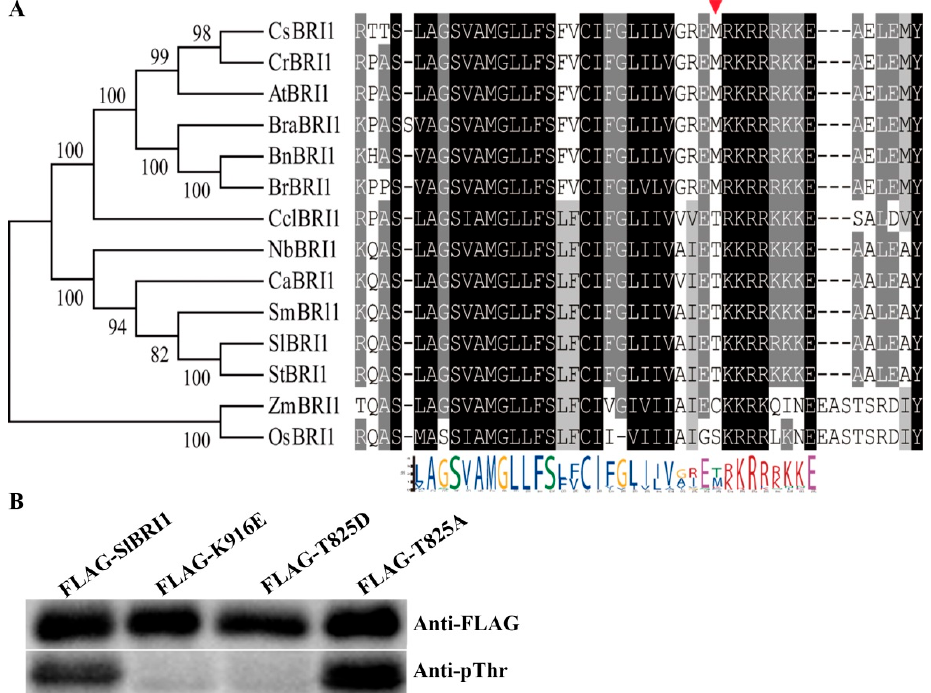
Figure 1. SlBRI1 Thr-825 influences the autophosphorylation of SlBRI1. ( A ) Sequence alignments of the partial kinase domains of BRI1 homologs. Gray and black regions indicate similar and conserved amino acids among BRI1 homologs, respectively. The red triangle shows the series of Thr-825 amino acids on BRI1 homologs. Conserved amino acids at individual sites are distinguished by different symbols with colors on the bottom. AtBRI1 ( Arabidopsis thaliana , NP_195650.1), SlBRI1 ( Solanum lycopersicum , NP_001296180.1), StBRI1 ( Solanum tuberosum , XP_006357355.1), SmBRI1 ( Solanum mel- ongena L., Sme2.5_00067.1_g00001.1), NtBRI1 ( Nicotiana tabacum, NP_001312072.1), BrBRI1 ( Brassica rapa, XP_009101880.2), BraBRI1 ( Brassica oleracea var. oleracea , XP_013597742.1), BnBRI1 ( Brassica na- pus , NP_001303105.1), OsBRI1 ( Oryza sativa , NP_001044077.1), ZmBRI1 ( Zea mays ,